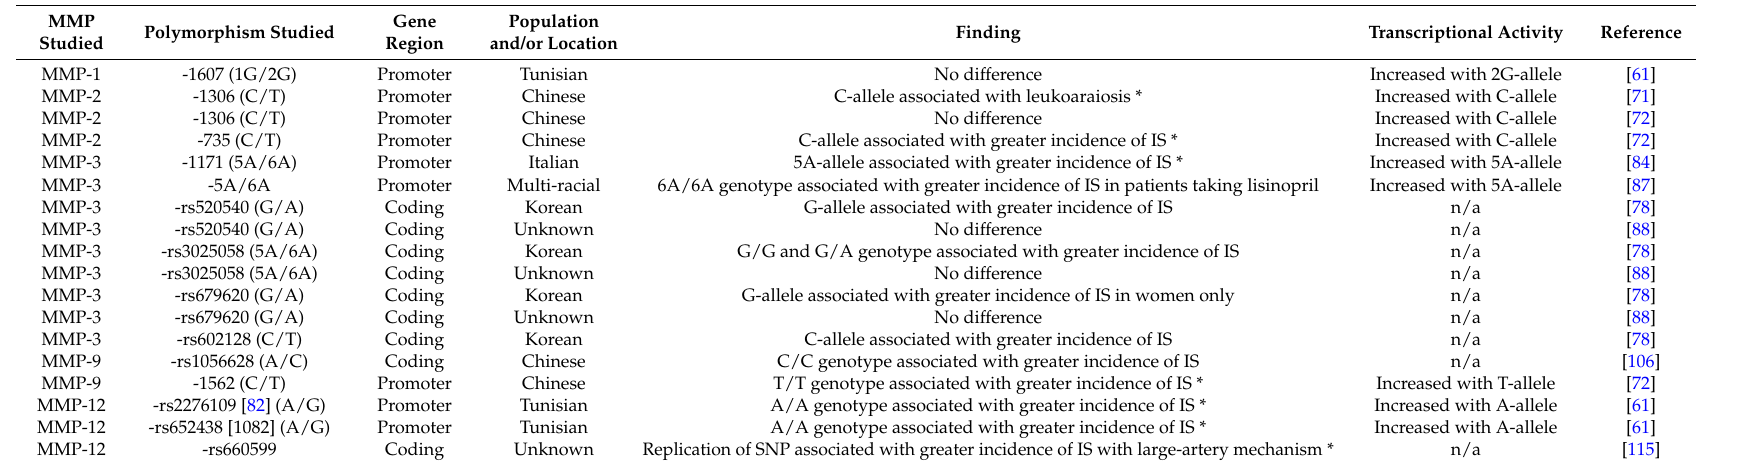
Table 2. MMP polymorphism relation to ischemic stroke